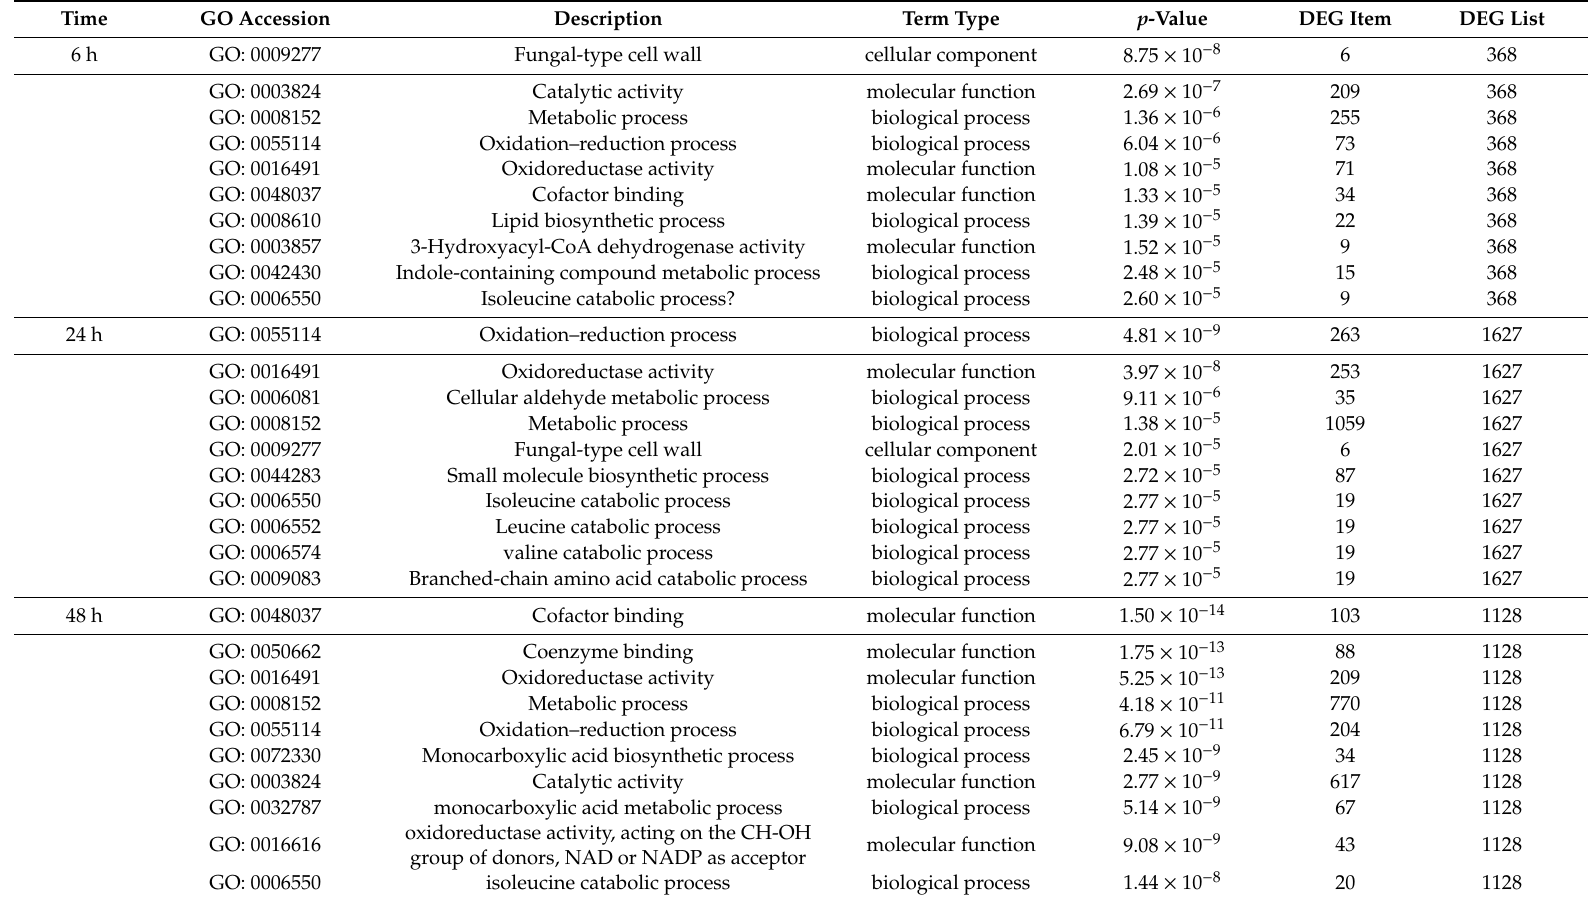
Table 3. GO enrichment analysis for di ff erent